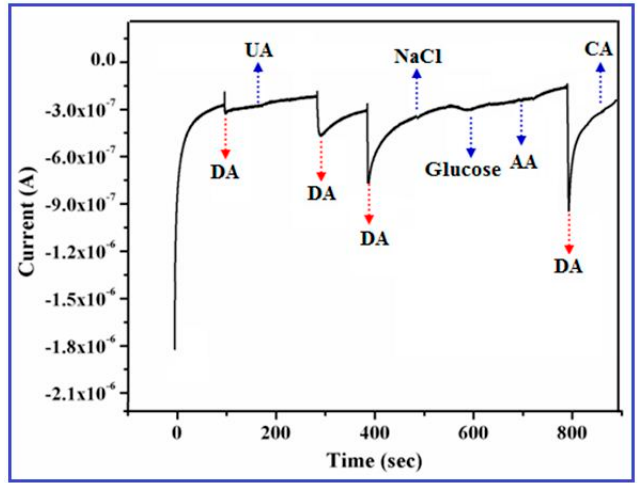
Figure 10. Interference study of the CuO nanowires/GCE recorded in 0.1 M phosphate buffer (pH 7.4) at a fixed potential of 0.15 V with the existence of UA, NaCl, AA, glucose and